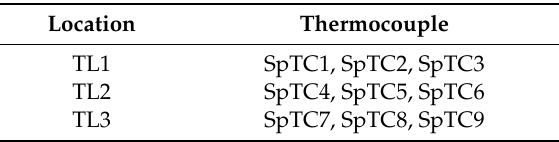
Figure 5. The side view of the furnace with column specimen. Table 1. Thermocouple notation on the